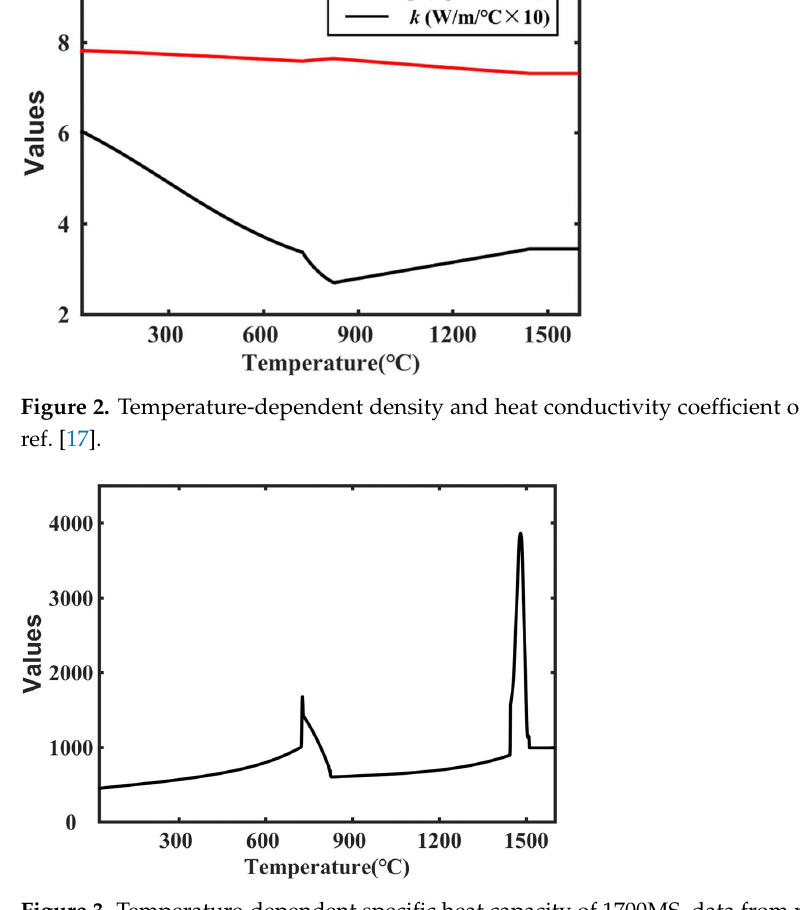
Figure 3. Temperature-dependent specific heat capacity of 1700MS, data from ref. [17].